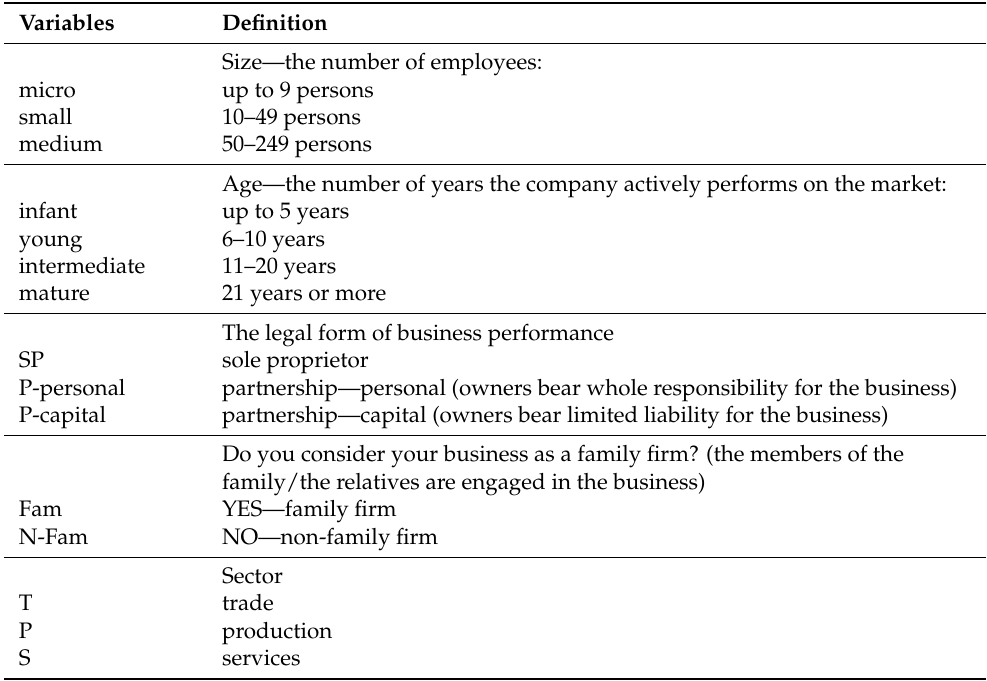
Table 4. The definitions of business demographic variables in the